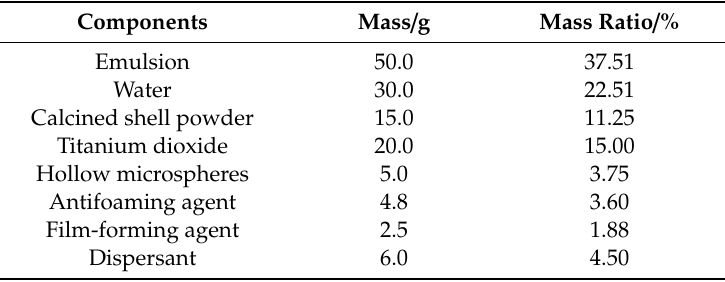
Figure 1. The calcination regime of shell powder. Table 1. Recipe of the thermal reflection